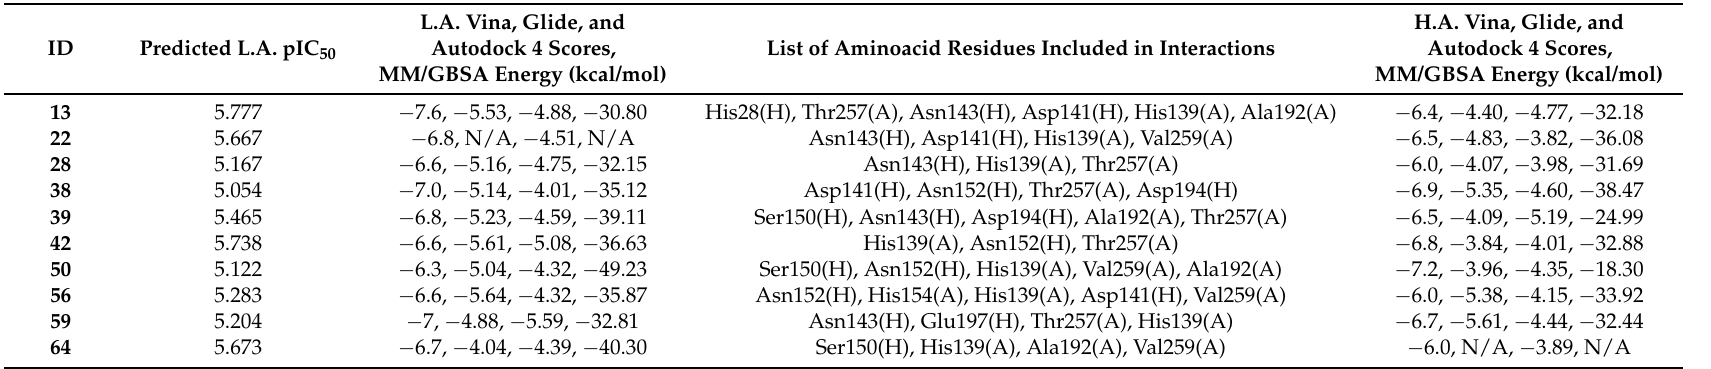
Table 2. List of docked compounds into Leishmania arginase homology model (L.A.) and human arginase crystal structure (H.A.) with QSAR calculated pIC 50 values for L.A., docking and MM/GBSA energies, and list of interacting aminoacid residues with